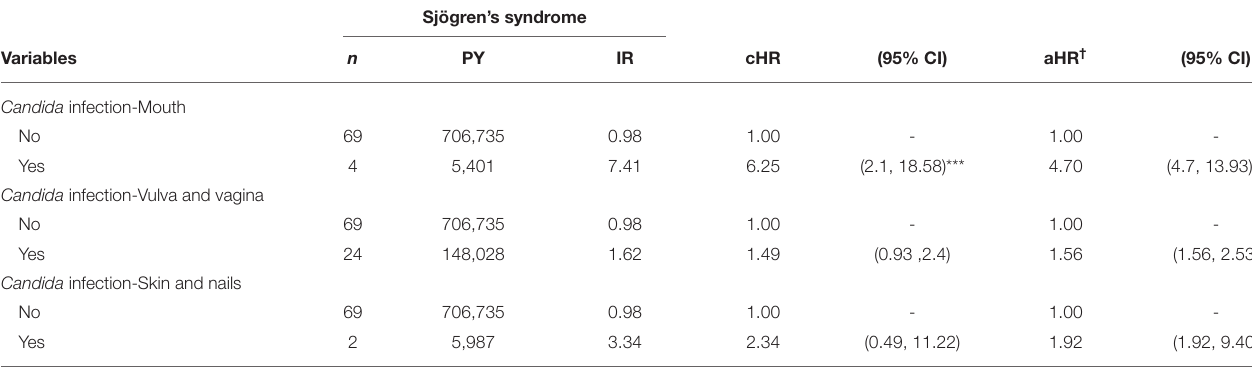
TABLE 4 | The risk of Sjögren’s syndrome in different sites of Candida infection.